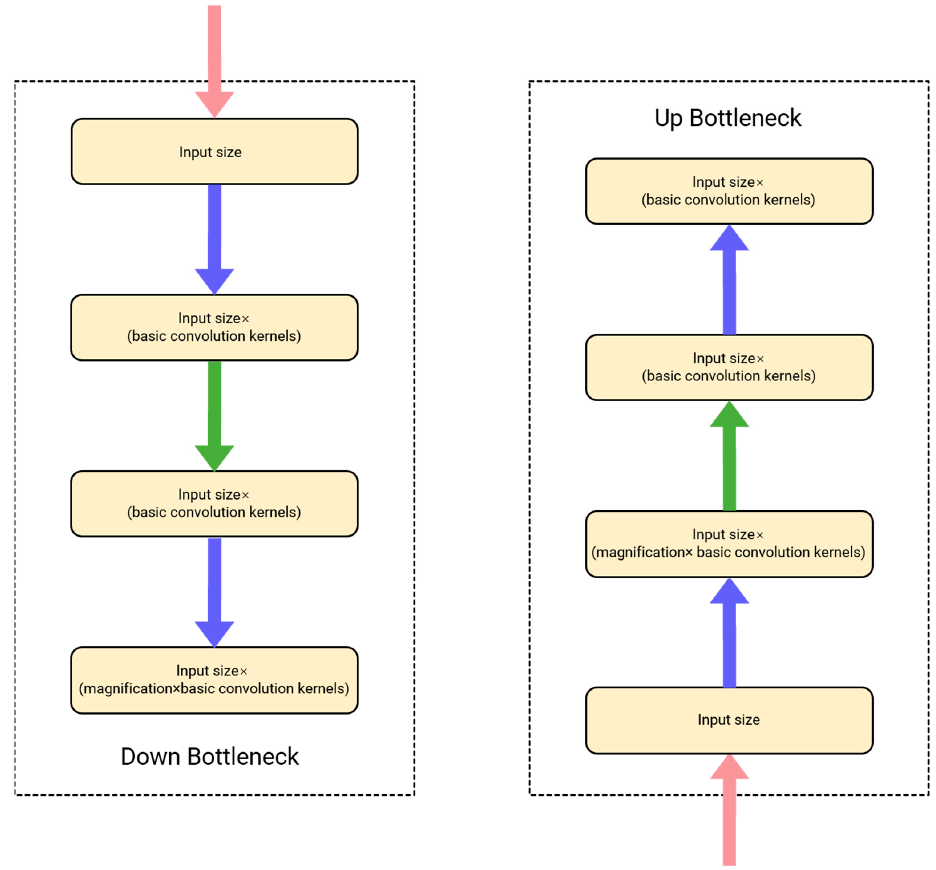
Figure 2. Architecture of the DownBottleneck module and the UpBottleneck